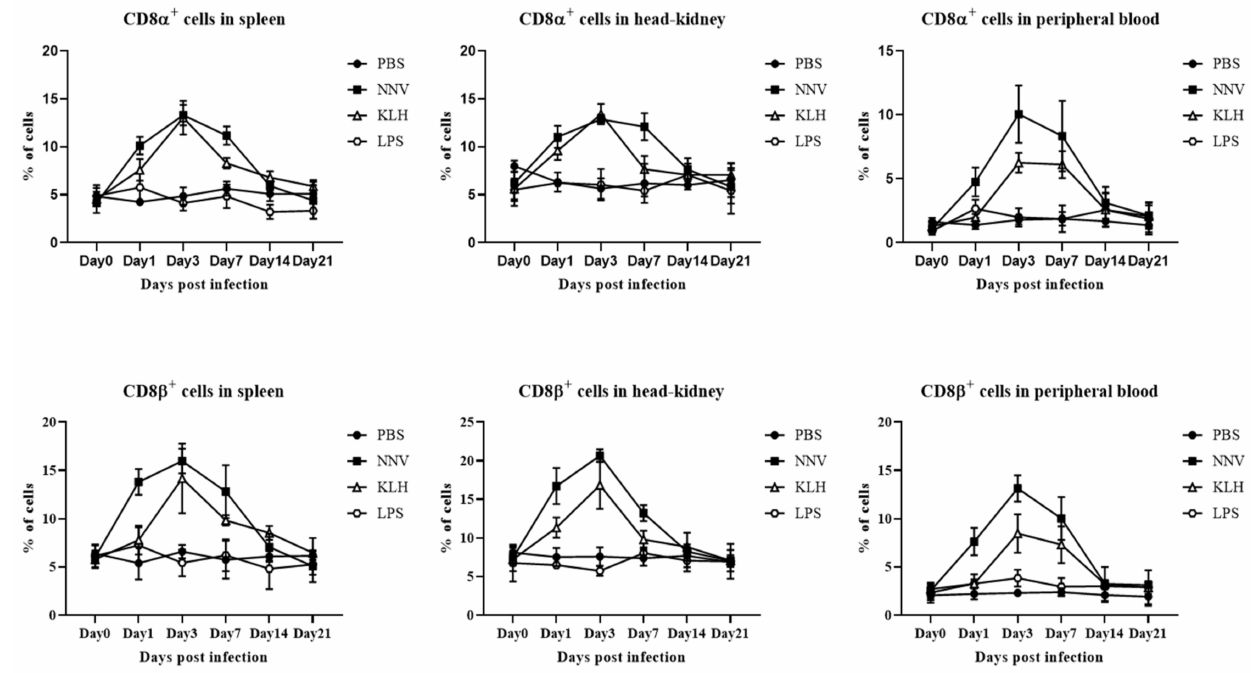
Figure 10. Variations in cytotoxic T cells after injection with NNV, KLH and LPS. Leukocytes from spleen, head-kidney and peripheral blood were obtained at 0, 1, 3, 7, 14 and 21 days post-administration, and incubated with anti-CD8 mAbs (3H9 or